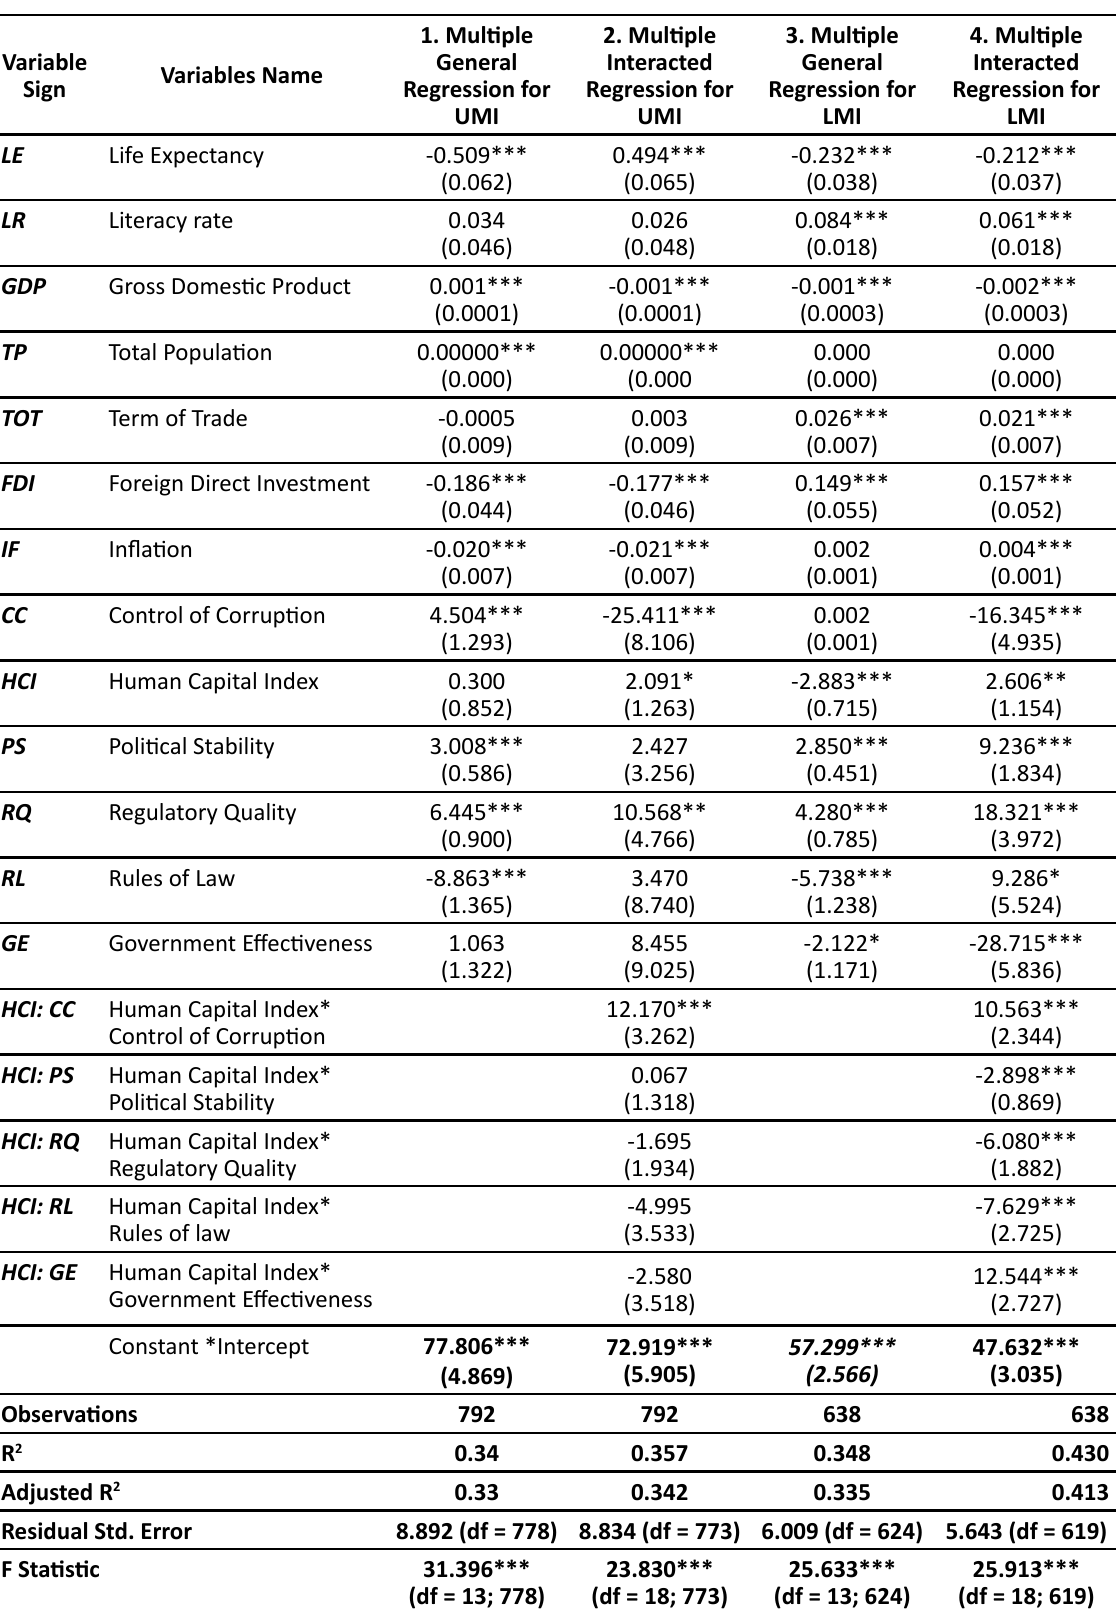
Table 3: Multiple General Regression and Multiple Interacted Regression Model in UMI and LMI